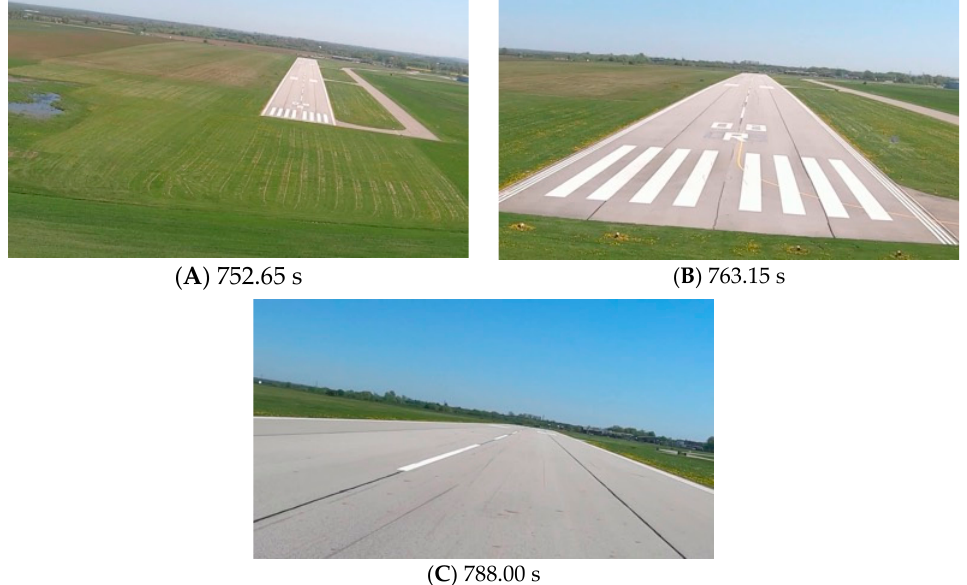
Figure 13. Recorded images related to the altitude measurements presented in Figure 12.